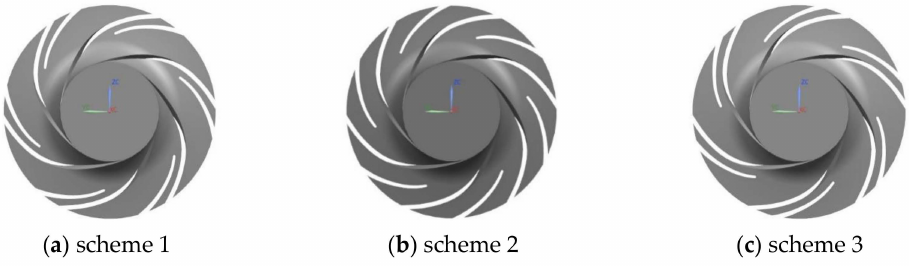
Figure 1. Impeller domains of the flow field calculation.